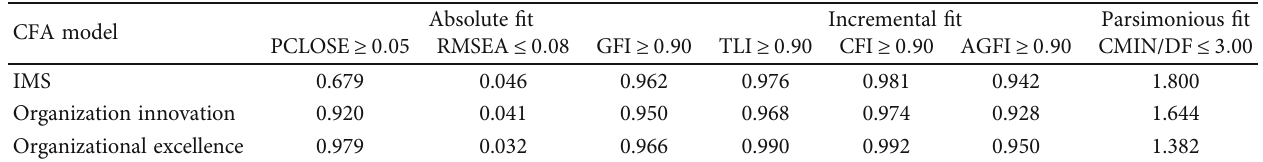
Table 9: Fit indices of measurement